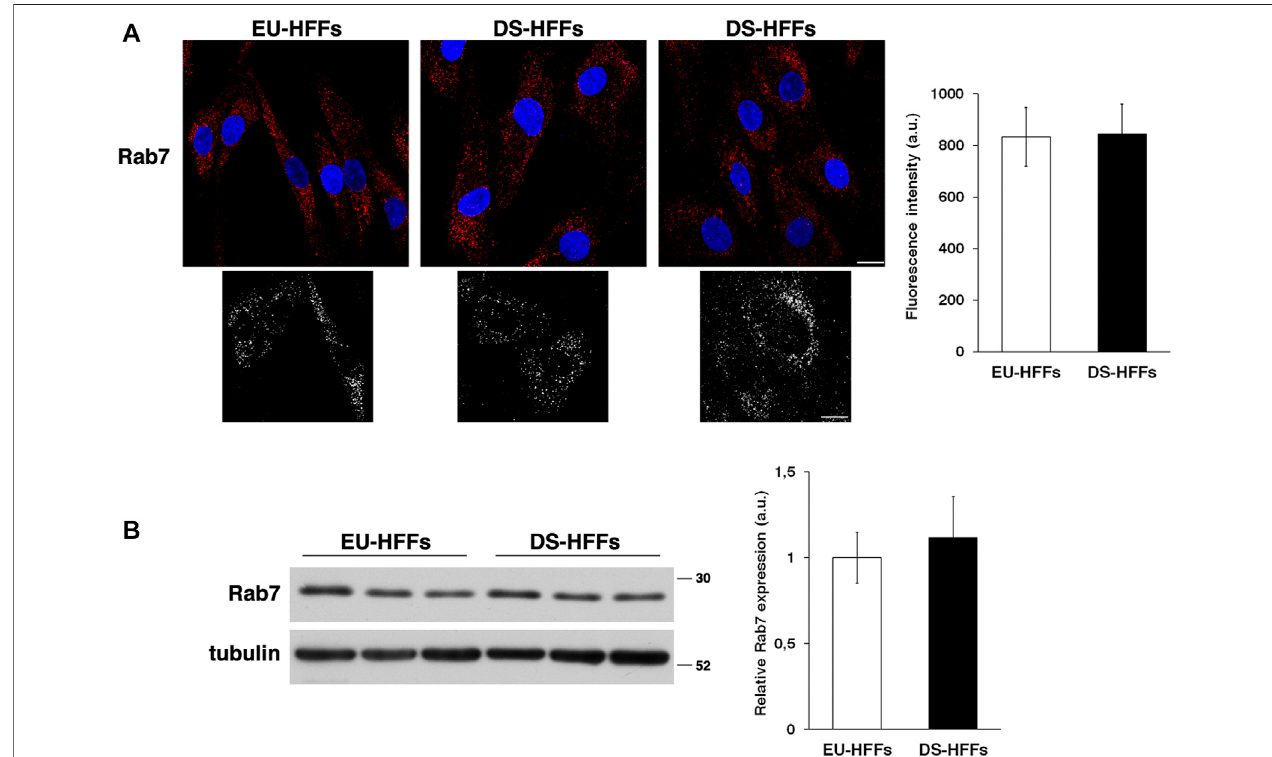
FIGURE2| Thehomeostasisoflate endosomes isnot altered inDS-HFFs. (A) EU-HFFs and DS-HFFs werestained withRab7 antibodydetected with Alexa-546- conjugated secondary antibodies. Serial confocal sections were collected from the top to the bottom of the cells. Representative images showing comparable late endosomes in both euploid and trisomic cells. For each condition, the 3D reconstruction is shown. Scale bars, 8 μ m. Mean fl uorescence intensity (arbitrary unit, a.u.) of Rab7-positivestructures isshown.Thebarsshowtherelative meanvalue±SDofthreeindependent experiments, n ≥ 50cells. (B) Representativeimmunoblotting ofRab7inDS-HFFsandEU-HFFs.Tubulinwasusedastheloadingcontrol.Themolecularweightofproteinmarkersisindicated.Densitometricanalysisofthreedifferent experiments, performed in three euploid and trisomic cultures, is shown. Error bars, mean ±